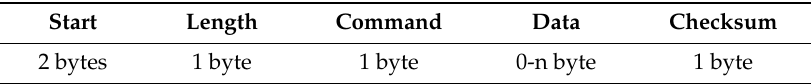
Table 2. The communication data frame format.